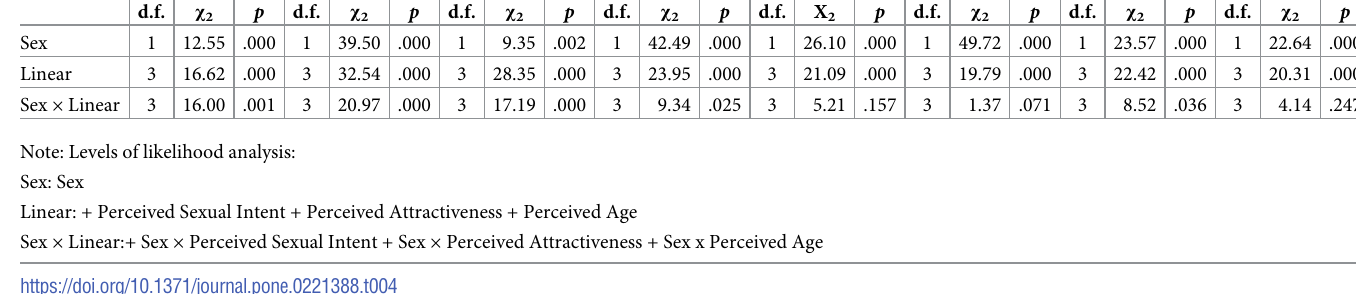
Table 4. Results of Likelihood Ratio Test on models of mental agency, mental experience, moral agency and moral patiency measure ratings of target women. Agency Patiency